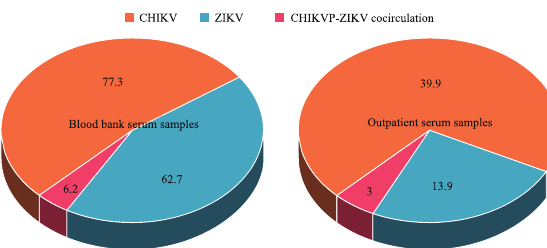
Fig. 4 Blood product source